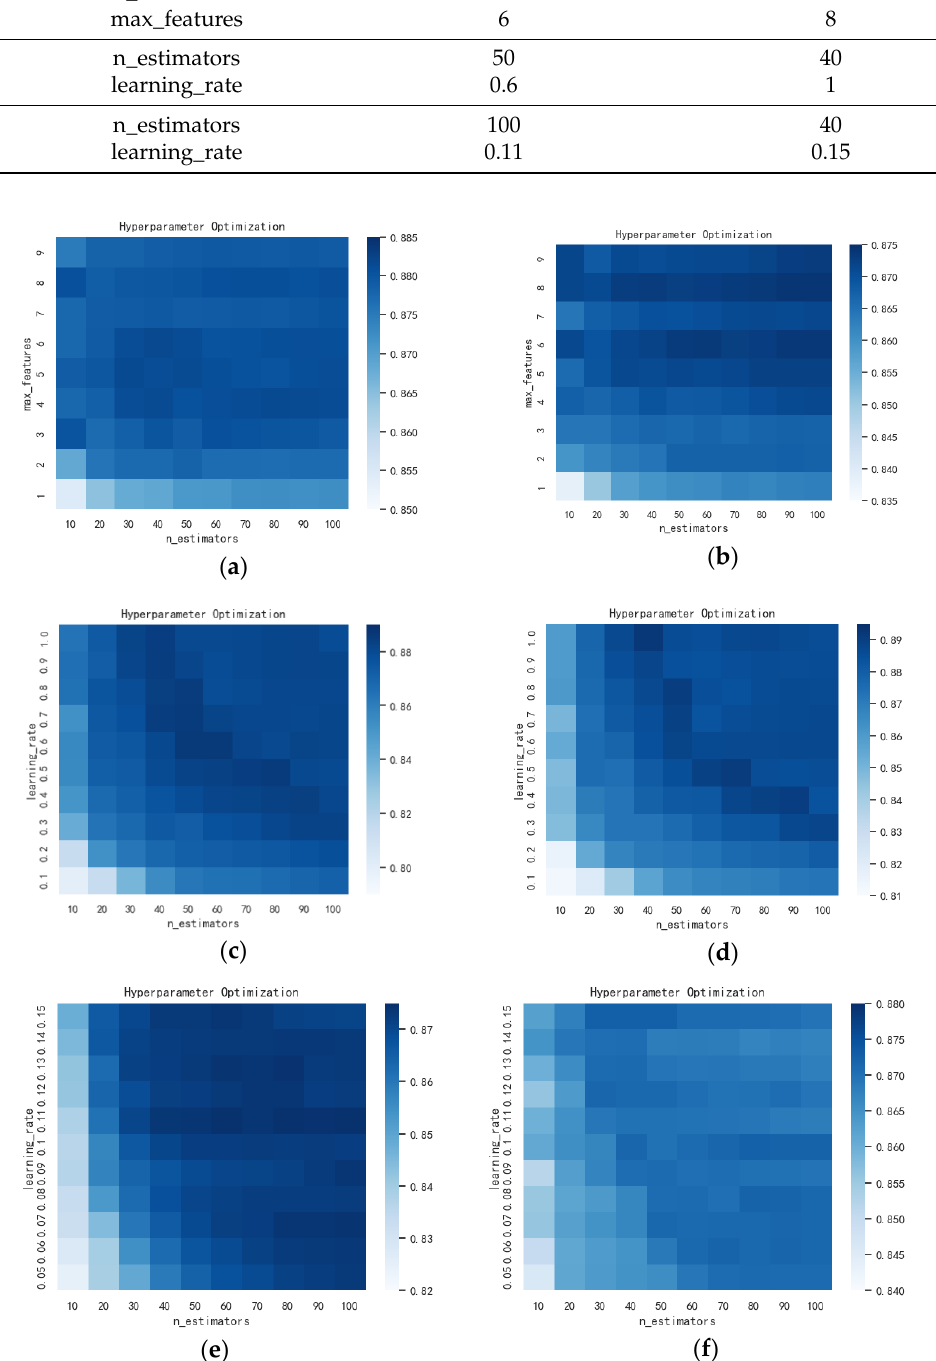
Figure 5. AUC values for different combinations of hyperparameters in Random Forest, AdaBoost, and XGBoost: ( a ) gaze — random forest; ( b ) secondary driving task — random forest; ( c ) gaze — AdaBoost; ( d ) secondary driving task — AdaBoost; ( e ) gaze — XGBoost; ( f ) secondary driving task — XGBoost. Table 10. Optimal hyperparameter values.